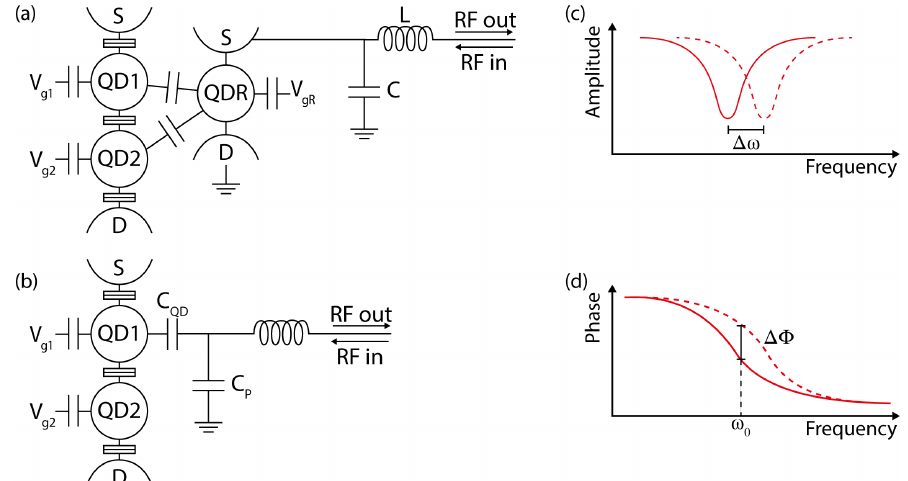
Figure 4. Schematics of two different reflectometry techniques. Panel ( a ) shows the rf-SET setup. A read-out quantum dot (QDR) is capacitively coupled to the double quantum dot, with different couplings to each dot. The single-electron transistor (SET) is highly sensitive to the charge configuration of the DQD thanks to the sharpness of the tunneling resonances. Configuration changes due to DQD tunneling events result in a strong change in the SET conductance. This can be observed by monitoring the signal reflected by the resonating circuit. Panel ( b ) shows the gate reflectometry configuration. In this case, the resonating circuit is directly connected to one of the gates controlling the DQD. Tunnel coupling between the QDs determine a change of the quantum capacitance that can be resolved as a frequency shift of the resonating circuit. This approach results in a simplified and more compact device, but is less performant as a readout technique. In both approaches a bias tee can be used to dc bias the rf lines, so that they can provide a source-drain bias or configure the QD (substituting V gQD 1 in this case). Panels ( c , d ) show the expected change in the reflected signal amplitude and phase in different configurations (dashed and non-dashed lines) for these readout